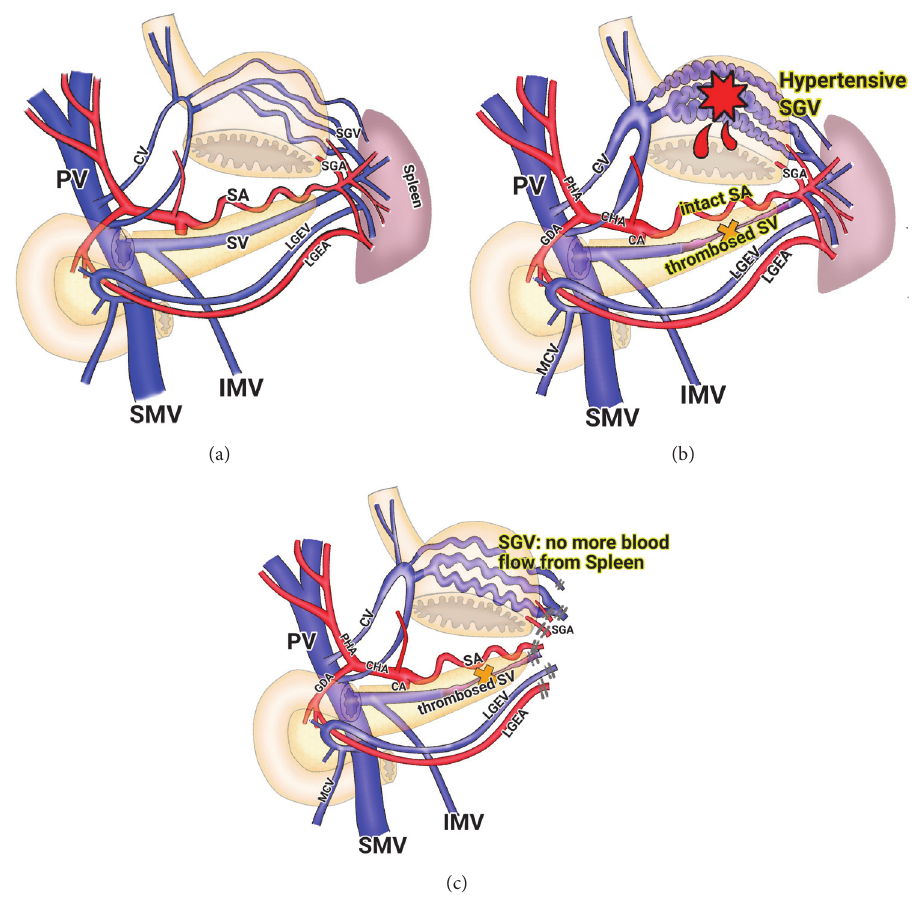
Figure 5: (a) Normal anatomy. The splenic inflows and outflows are balanced. (b) Thrombosed splenic vein and intact splenic artery induces hypertensive short gastric veins. It is a potential source of massive bleeding from gastric varices. (c) The rationale of splenectomy in the setting of gastric variceal bleeding is the complete interruption of blood flow in short gastric veins from spleen. PV, portal vein; SMV, superior mesenteric vein; CV, coronary vein; IMV, inferior mesenteric vein; SA, splenic artery; SV, splenic vein; LGEA, left gastroepiploic artery; LGEV, left gastroepiploic vein; SGA, short gastric artery; SGV, short gastric vein.